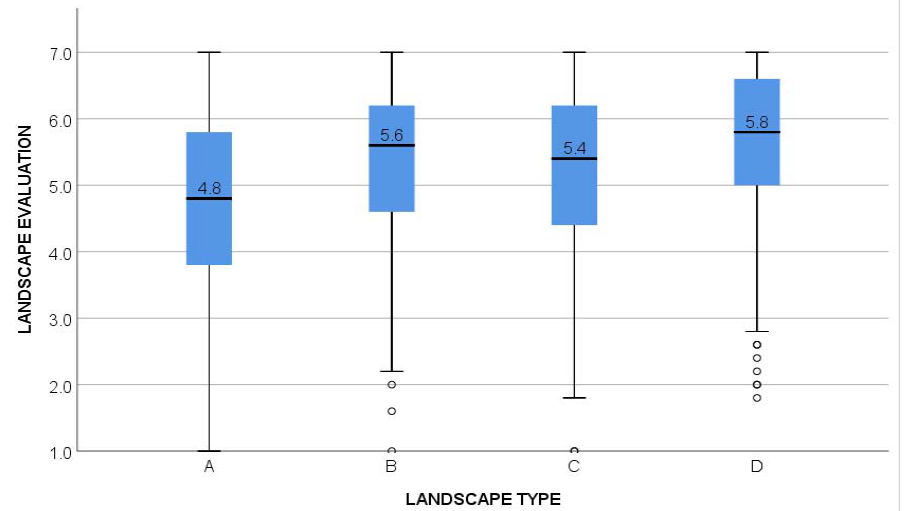
Figure 3. Average evaluation of each landscape A–D as assessed by respondents, who were asked to evaluate the depicted landscapes based on their aesthetic preferences using a 7-point Likert-type scale ranging from 1 (very ugly) to 7 (very beautiful).